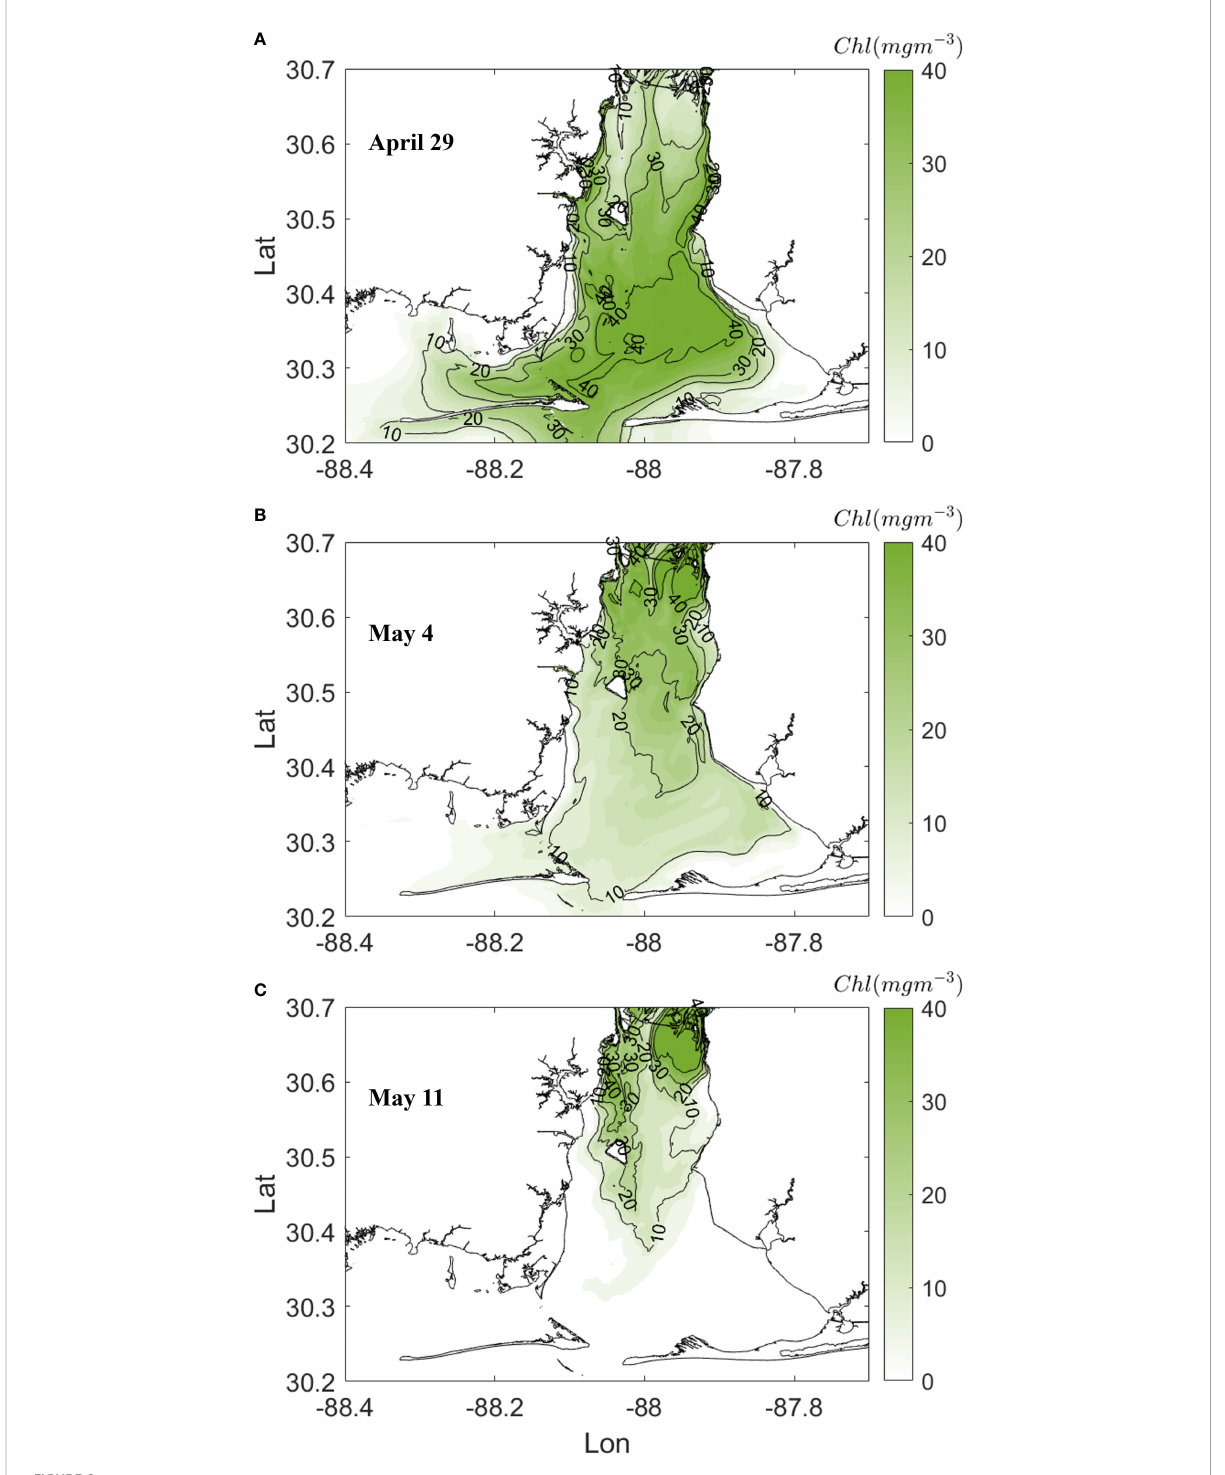
FIGURE 8 Spatial patterns of surface chlorophyll (Chl) concentration before (A) , during (B) and after (C) the hypoxia event in early May